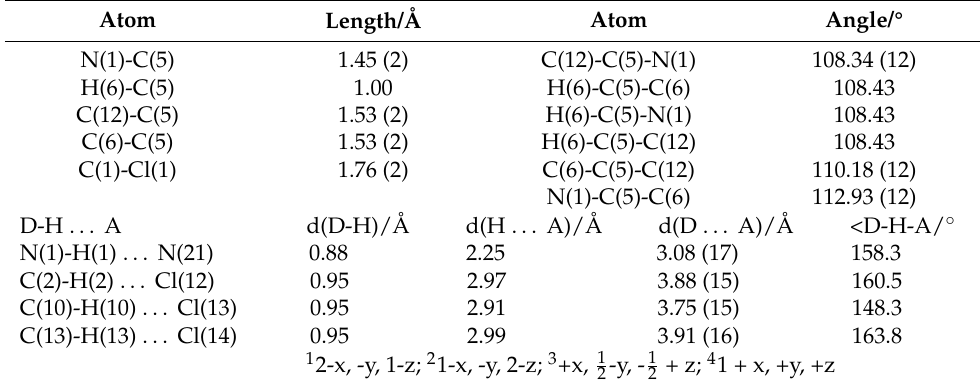
Figure 1. The ORTEP diagrams of L b with the thermal ellipsoids drawn at the 50%. Atoms color: (a) blue = nitrogen, (b) pink = hydrogen, (c) green = chlorine, (d) grey = carbon. Table 1. Selected geometric parameters for L b